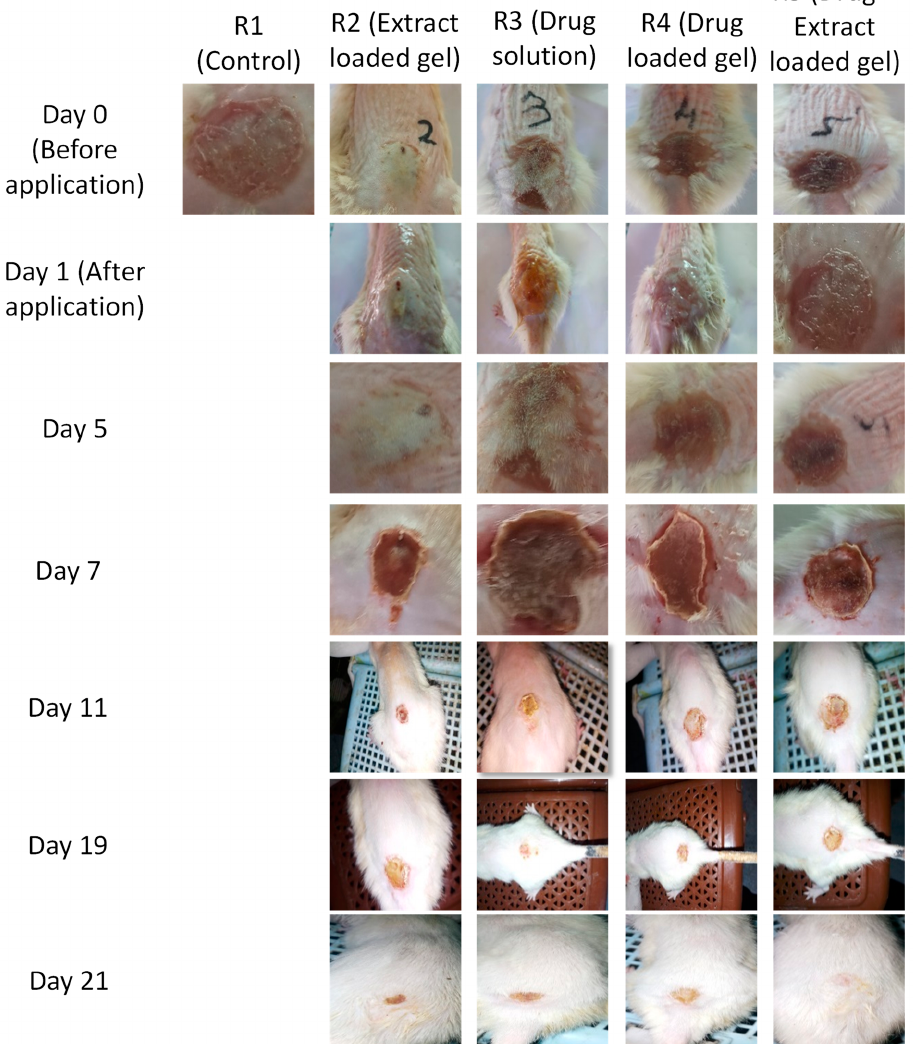
Figure 7. Effect of different nanogels on wound contraction in rat models. Percent wound contraction in burn wound injury rat models, using different formu- lations, was no observed throughout the period of study (21 days). It was observed that there was a significant reduction in the wound area from day 1 to day 21. In comparison to the control group, where no treatment was applied on the wound, the treated groups show significant reduction in wound area and healing. The order of % wound area con- traction was in following order: R5 (89.9%) > R4 (84.7%) > R3 (81.3%) > R2 (78.8%) >R1 (71.1%). ANNOVA gives significant results in all formulation, with a p value < 0.0001. Multiple comparison models of all formulations show a significant reduction in wound area, with the passage of days from day 1 to day 21. All formulation give p value < 0.0001, in comparison to control group R1. The trend remains to be significant in all